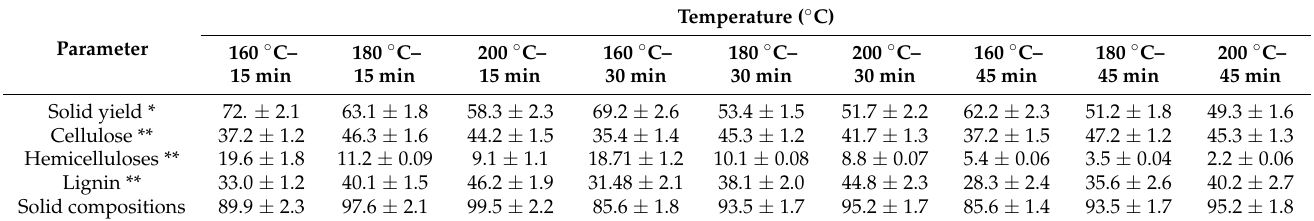
Table 2. Chemical compositions of the apple orchard waste after pretreatment at various temperatures. (Data represents mean ± standard deviation, n =